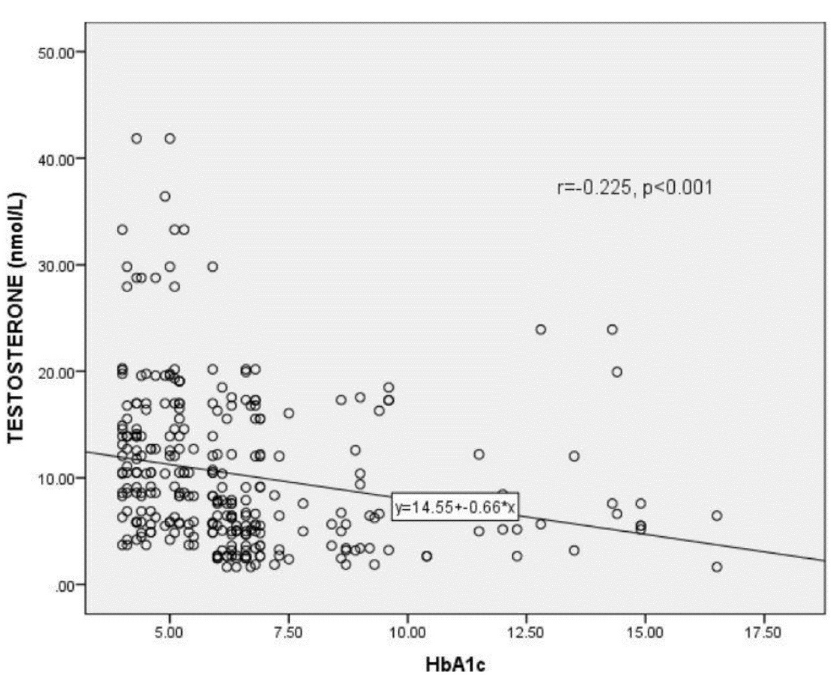
Fig 2. Correlation between testosterone levels and glycated hemoglobin (HbA1c) levels among the study participants. HbA1c = Glycated haemoglobin, r = Correlation coefficient. p < 0.05 was considered statistically